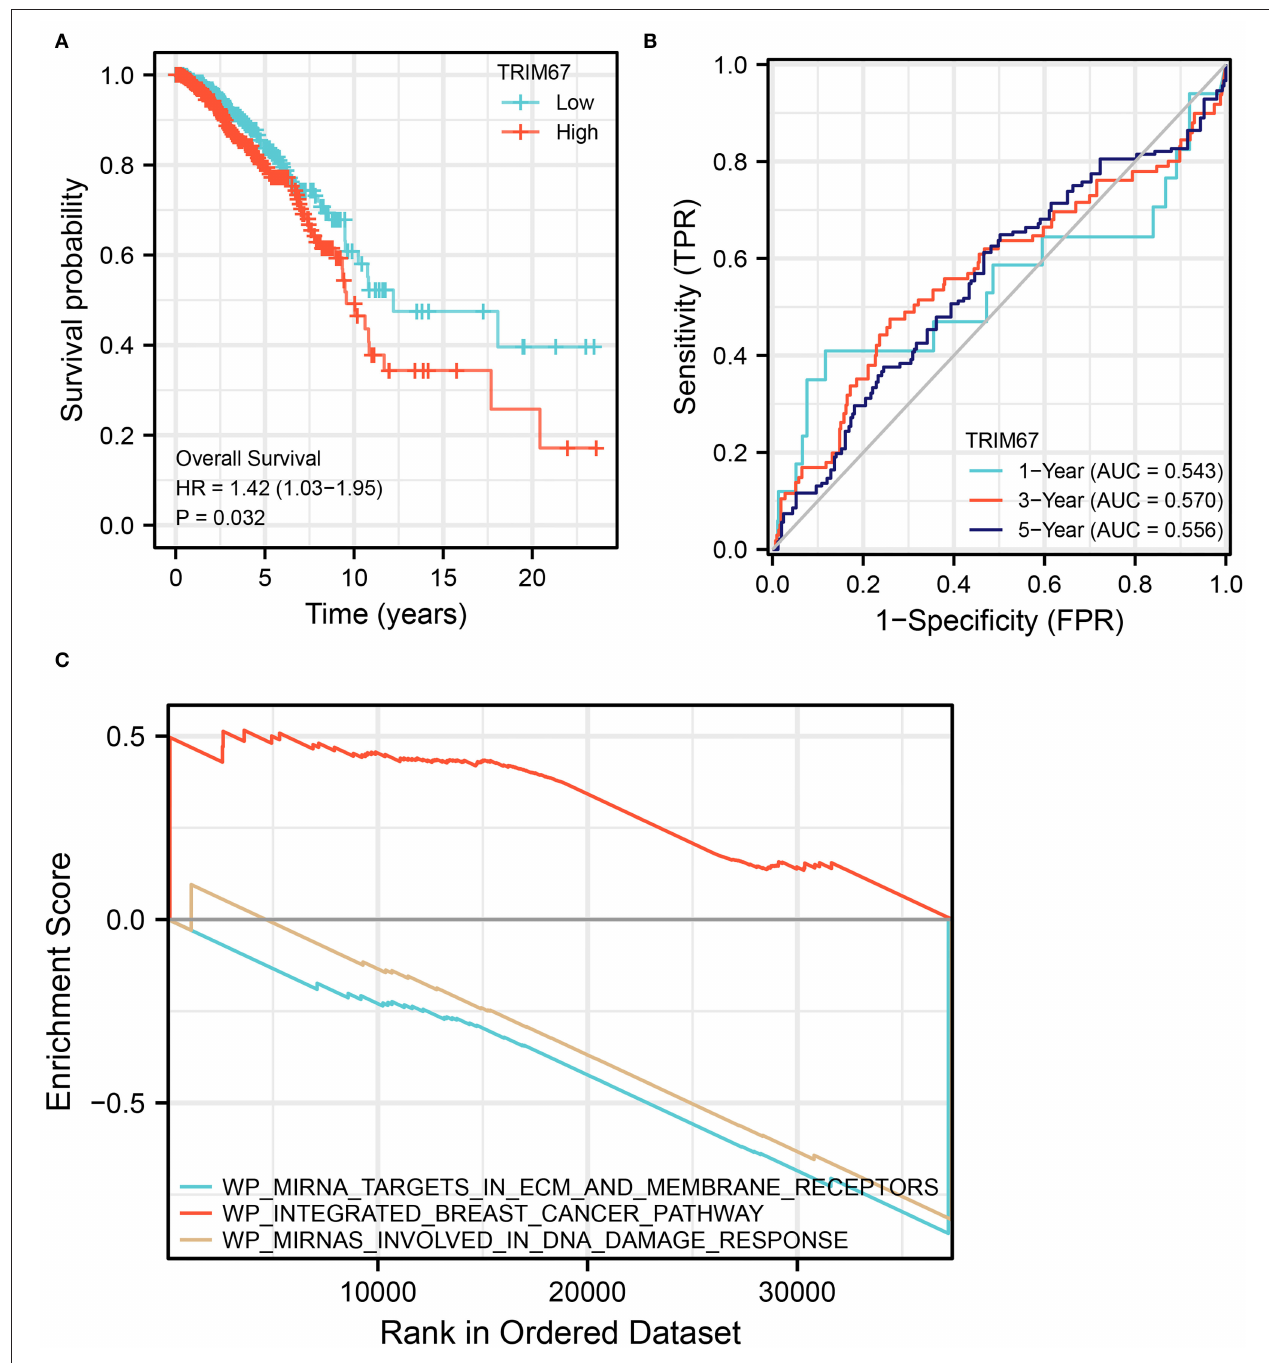
FIGURE 6 | Survival analysis and GSEA for TRIM67 . (A) KM curves showed significant differences ( p = 0.032) in survival curves between high and low TRIM67 groups for patients with breast cancer; (B) ROC shows the predictive power of TRIM67 for overall survival at 1, 3, and 5 years; (C) GSEA shows the functional pathways that are enriched when TRIM67 is